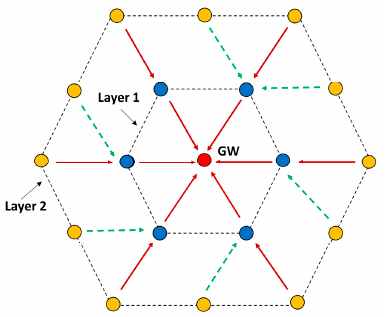
Figure 7. Hexagonal Topology.